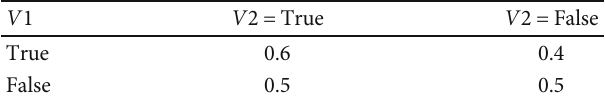
Table 2: Conditional probability table of node V 2 .